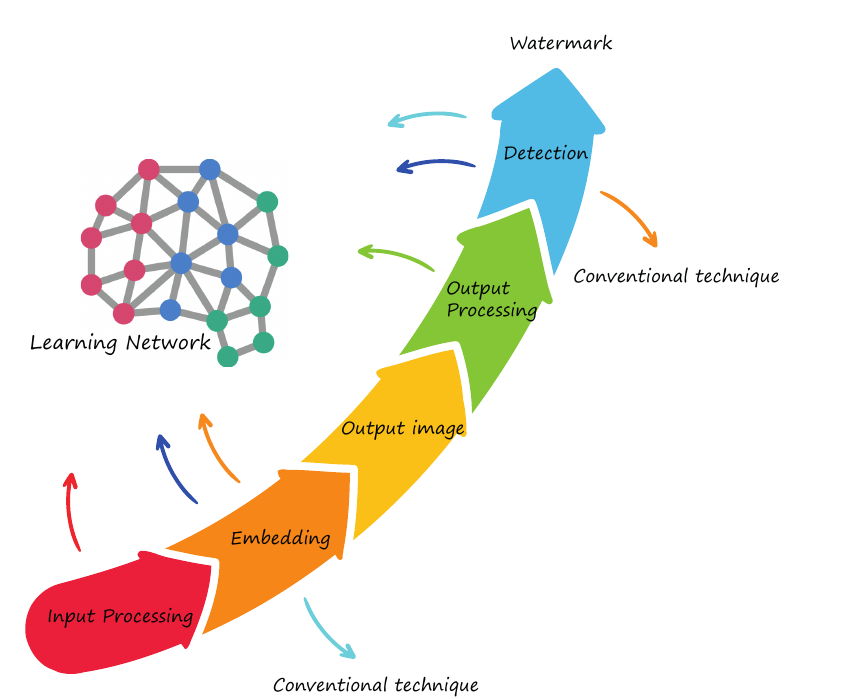
Figure 9. Brief diagram of the learning framework in the image watermarking process. The network was trained either to insert the watermark (orange line) or to detect the watermark (sky blue line). The scenario in which both embedding and detection are performed by a trained network is represented by the dark blue line, while input processing and output processing using learning networks are shown by the red line and the green line,